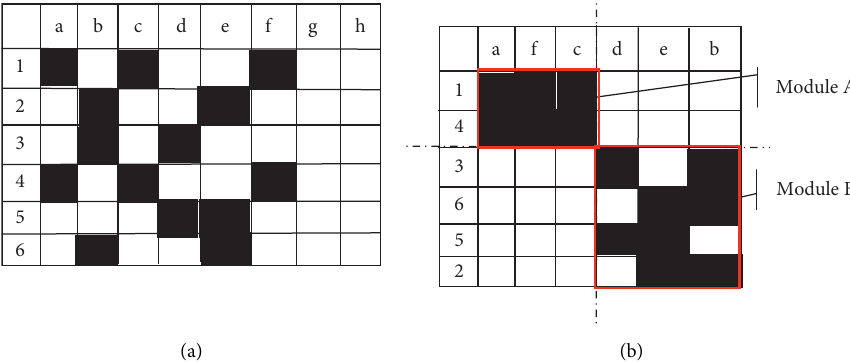
Figure 2: DDM correlation matrix and clustering. (a) DDM mapping establishment; (b) DDM